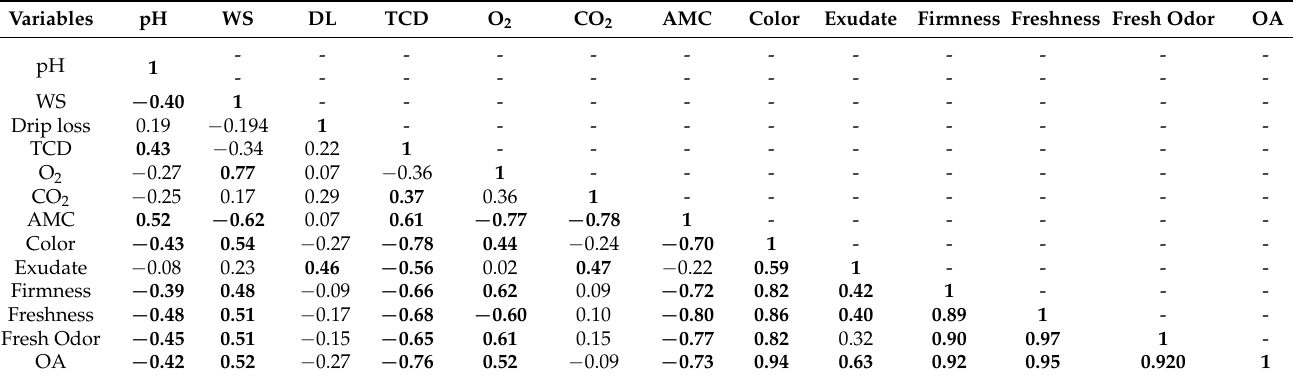
Table 3. Pearson correlation coefficient matrix between quality indicators measured in Cape hake fillets during